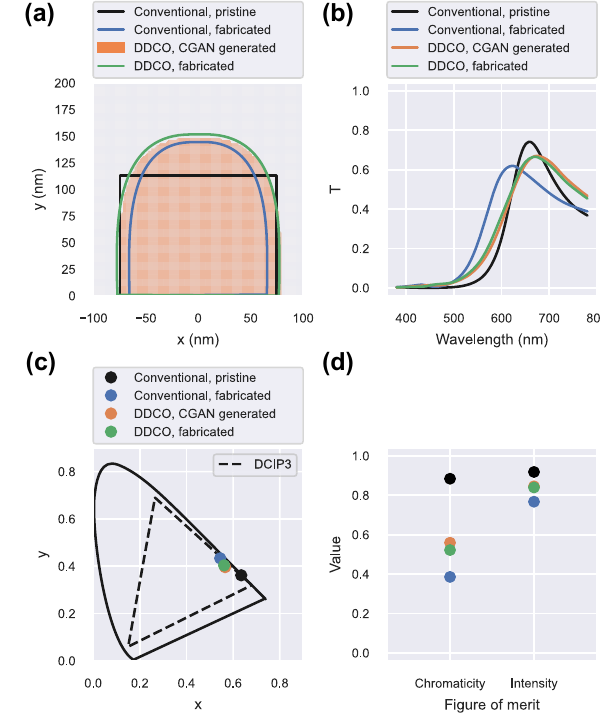
Figure 5: Optimization